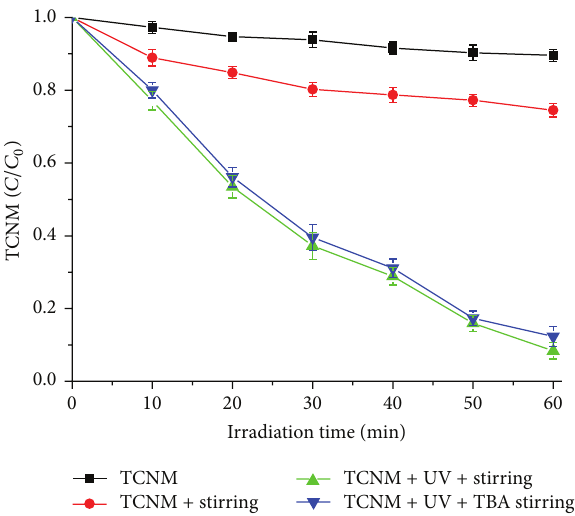
Figure 3: Effect of light intensity on the photodegradation of